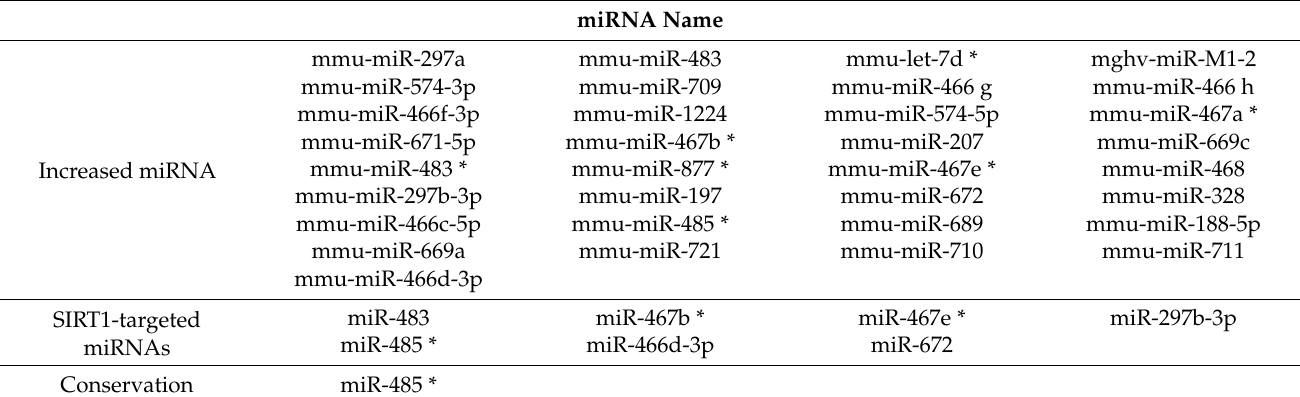
Table 2. Selection of putative SIRT1-targeting miRNAs in the liver after APAP overdose. miRNA Name